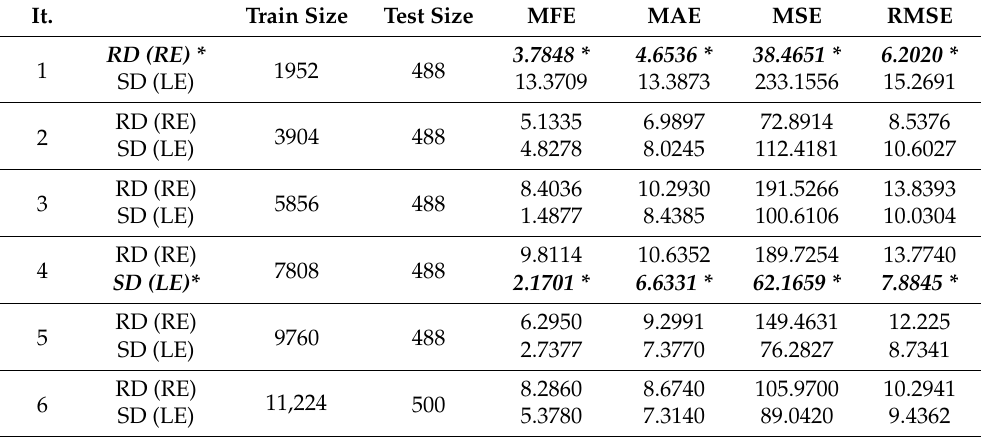
Table 3. Results of the forecasting analysis performed with heart rate data measurements for both RD and